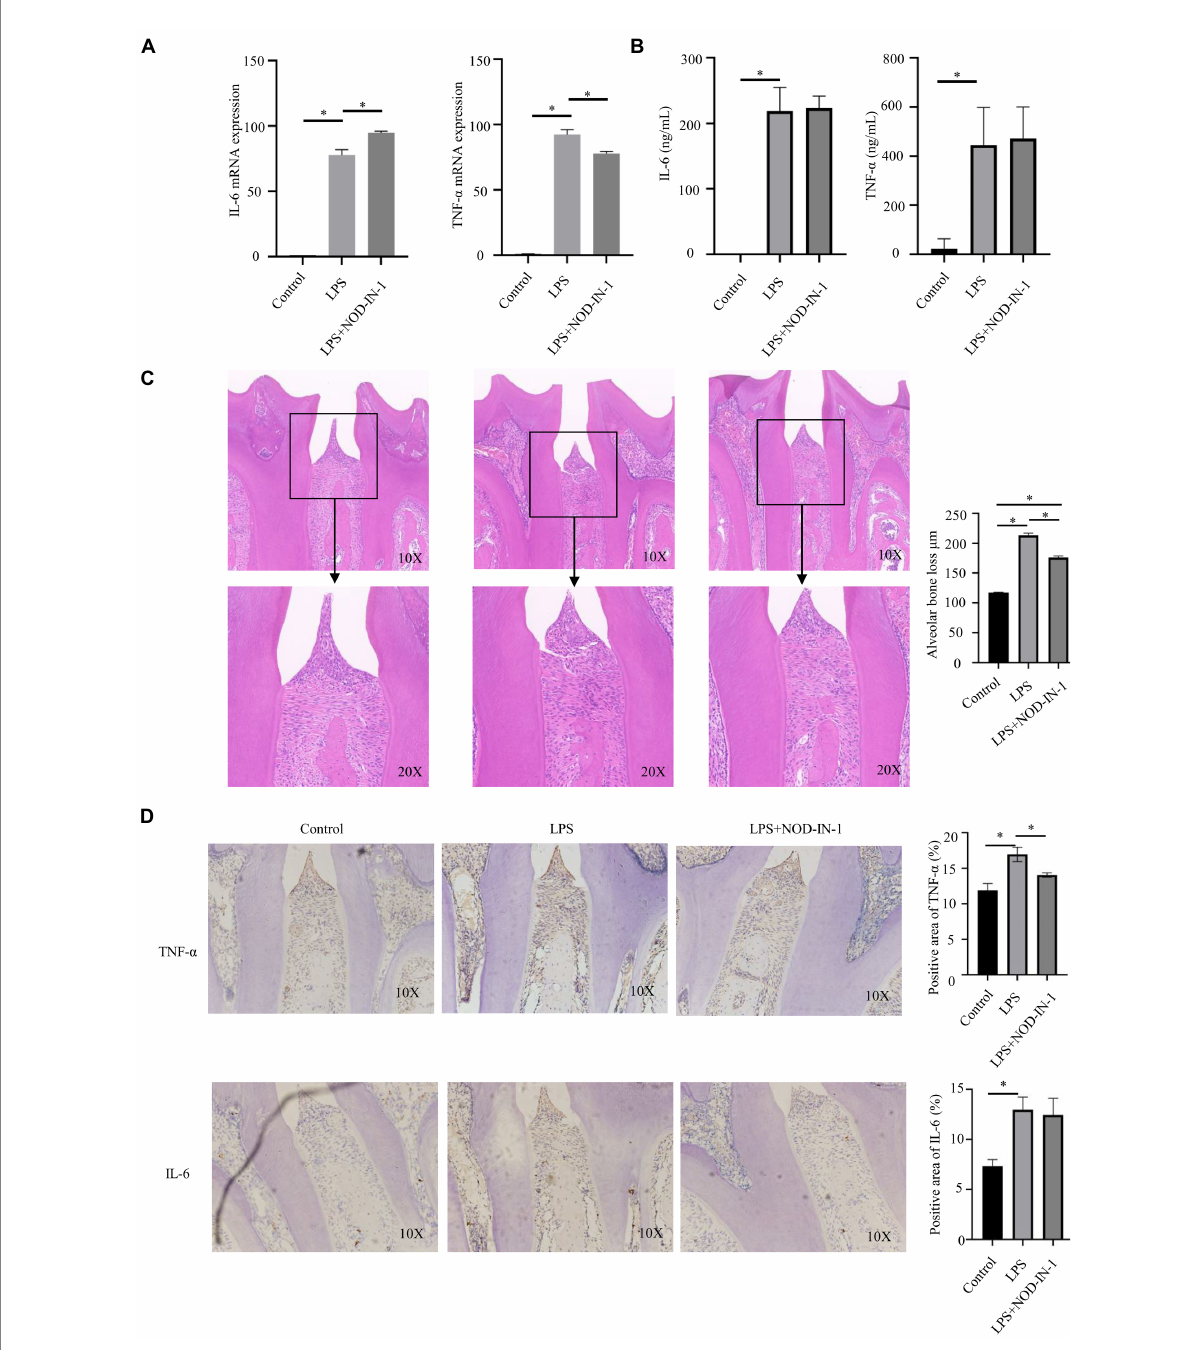
FIGURE 5 Effect of NOD-IN-1 on P. intermedia LPS-induced periodiontitis inflammation in vitro and in vivo . (A) Cells were treated with P . intermedia LPS (10 μ g/mL) in the absence or presence of NOD-IN-1 for 24 h; then, real-time polymerase chain reaction was carried out for the measurement of Il-6 , and Tnf- α mRNA expression. The results are presented using mean ± standard deviation values of 3 independent experiments. * p < 0.05. (B) Enzyme-linked immunosorbent assay results showing the levels of IL-6, and TNF- α in RAW 264.7 cells treated with P . intermedia LPS in the presence or absence of NOD-IN-1. (C) Representative hematoxylin and eosin images of periodontium after P . intermedia lipopolysaccharide injection with or without NOD-IN-1 application and quantitative measurement of attachment loss. (D) Representative immunohistostaining of TNF- α and IL-6 in the periodontium and the quantitative measurement of their